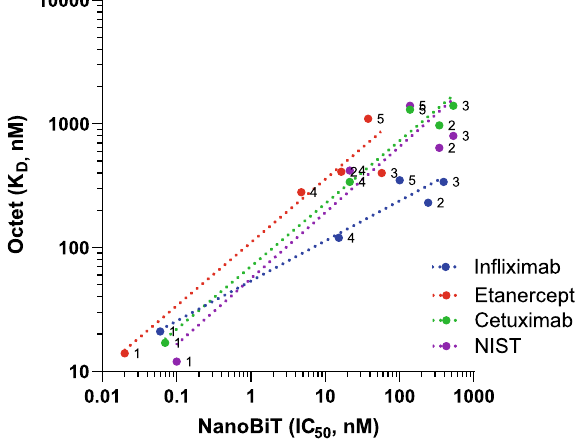
Figure 6. Correlation plot between affinity (IC 50 ) determined using NanoBiT assays and affinity (K D ) determined using BLI platform. IC 50 (nM) and K D (nM) were determined for binding of Infliximab, Etanercept, Cetuximab and NIST to (1) FcgRI, (2) FcgRIIa (H131), (3) FcgRIIa (R131), (4) FcgRIIIa (V158), and (5) FcgRIIIa